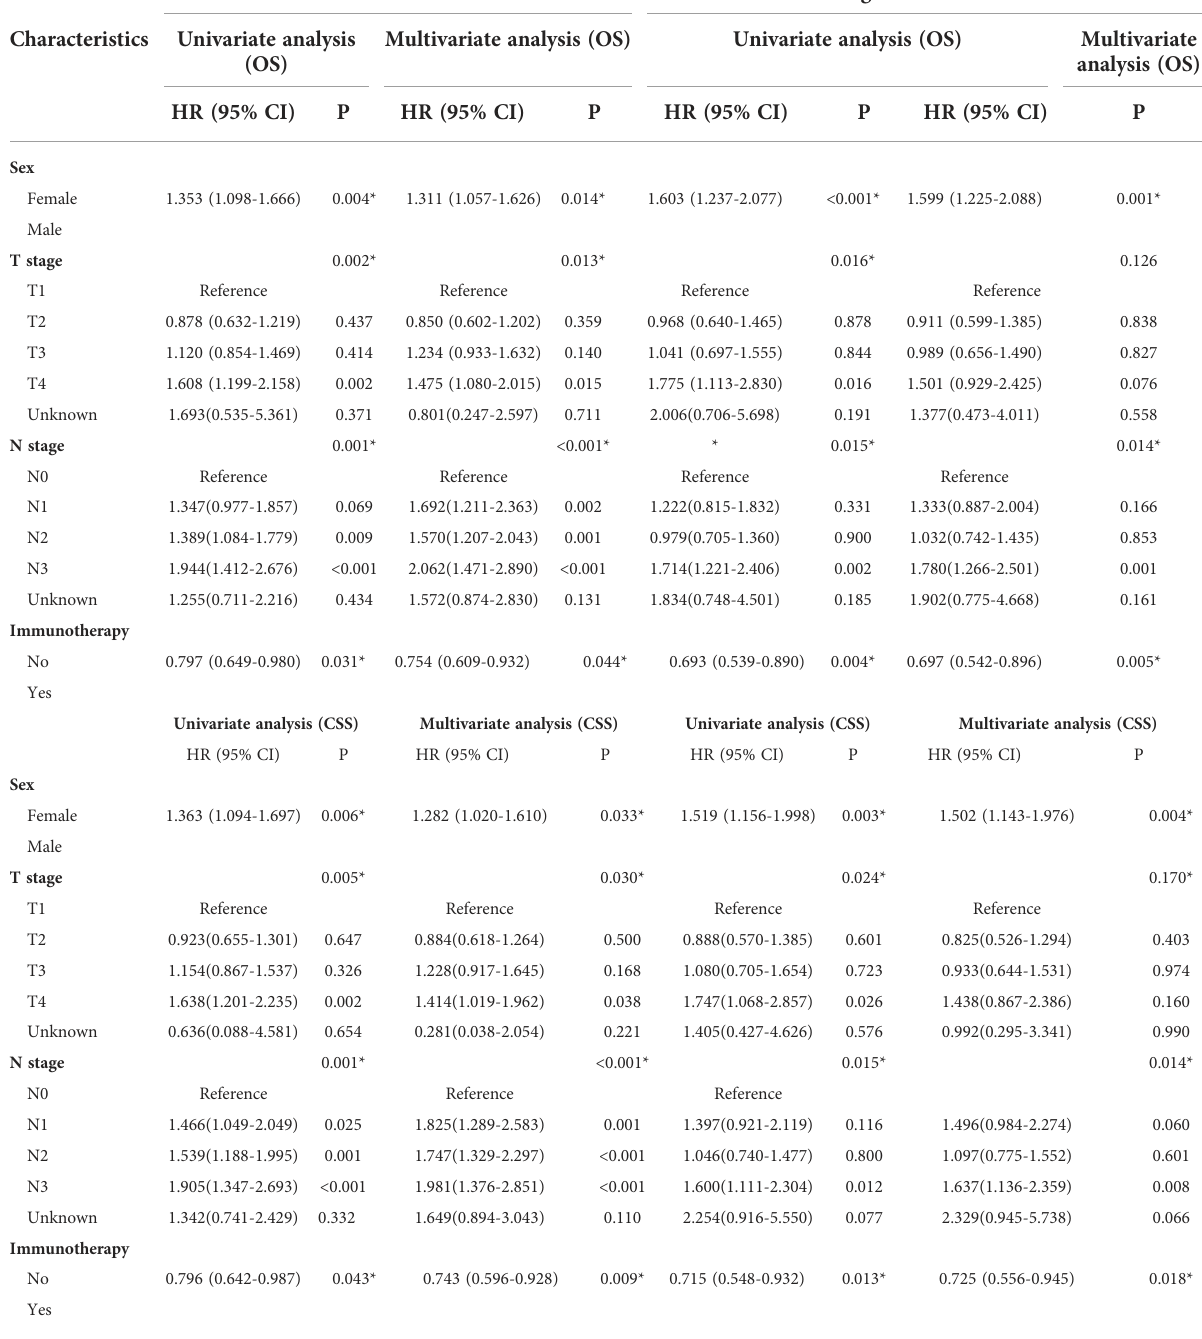
TABLE 3 Univariate and multivariate analyses of OS and CSS for different characteristics of oligometastatic NSCLC in each cohort. SEER Cohort